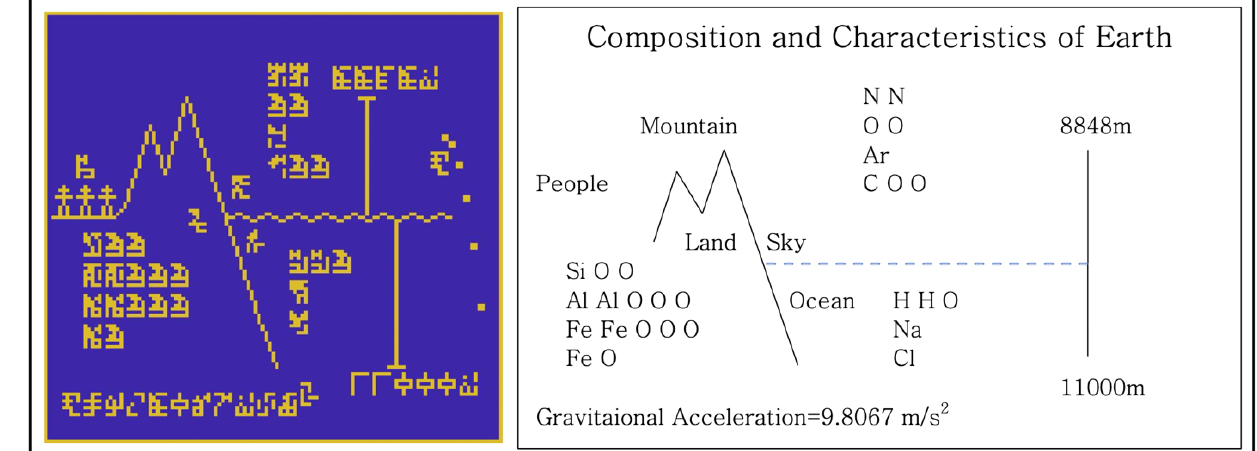
Figure 17. Earth compositional breakdown in the Message, Page 11.